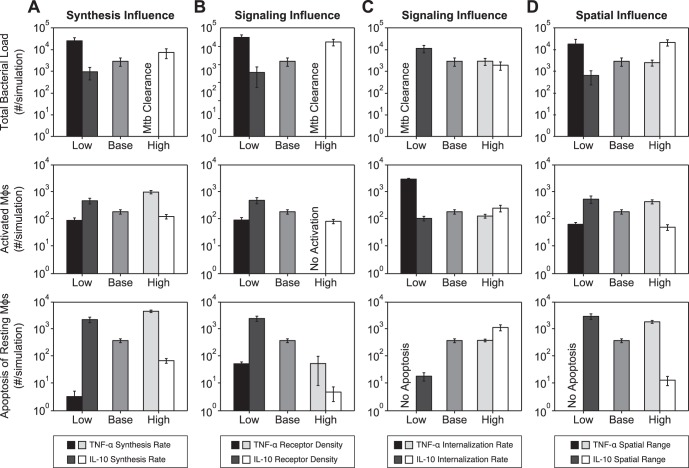
Simulation results showing the effects of varying each influence in a granuloma environment.Simulation results from 30 replications showing the effects of varying each of the three influences: the synthesis influence, signaling influence, and spatial influence (Figure 5; Table S4 and Table S5 in Appendix S3). Results using the baseline containment parameter set, labeled ‘base’, are included for comparison (parameter values in Table S4 in Appendix S3 and Table S5 in Appendix S3). A. Effects of mRNA synthesis rate of TNF-α by Mφ (‘Low’ kRNA_Mac = 0.5 #/cell*s, ‘High’ kRNA_Mac = 3.0 #/cell*s) and synthesis rate of IL-10 by activated Mφ (‘Low’ ksynthMacAct = 0.1 #/cell*s, ‘High’ ksynthMacAct = 1.0 #/cell*s). B. Effect of TNFR1 receptor density on Mφ (‘Low’ TNFR1mac = 500, ‘High’ TNFR1mac = 5000) and IL-10R receptor density on Mφ (‘Low’ IL10Rmac = 500, ‘High’ IL10Rmac = 5000). C. Effect of bound TNFR1 internalization rate constant (‘Low’ kint1 = 10−4 s−1, ‘High’ kint1 = 10−3 s−1) and bound IL-10R internalization rate constant (‘Low’ kint = 10−4 s−1, ‘High’ kint = 10−3 s−1). D. Effect of spatial range of TNF-α (‘Low’ DTNF = 1×10−8 cm2/s kdeg = 2.3×10−2 s−1, ‘High’ DTNF = 9×10−8 cm2/s kdeg = 5×10−5 s−1) and spatial range of IL-10 (‘Low’ DIL10 = 1×10−8 cm2/s kdeg = 1.6×10−2 s−1, ‘High’ DIL10 = 8×10−8 cm2/s kdeg = 1.8×10−6 s−1). Low indicates a lower value than baseline while high indicates a higher value than baseline.